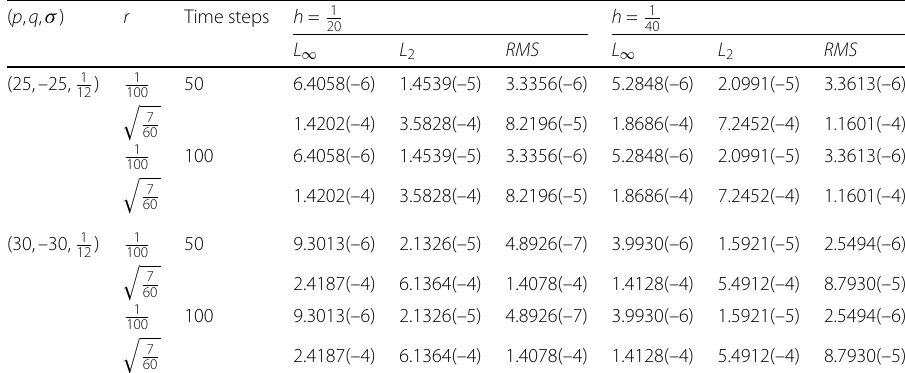
Table 3 L ∞ , L 2 and RMS errors for Example 2